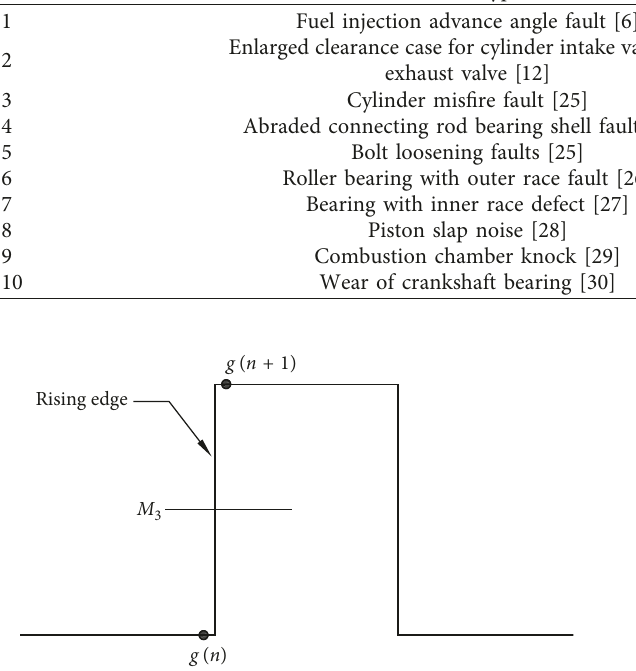
Figure 8: Judgment method of the rising edge. When g smaller and g exist between points.